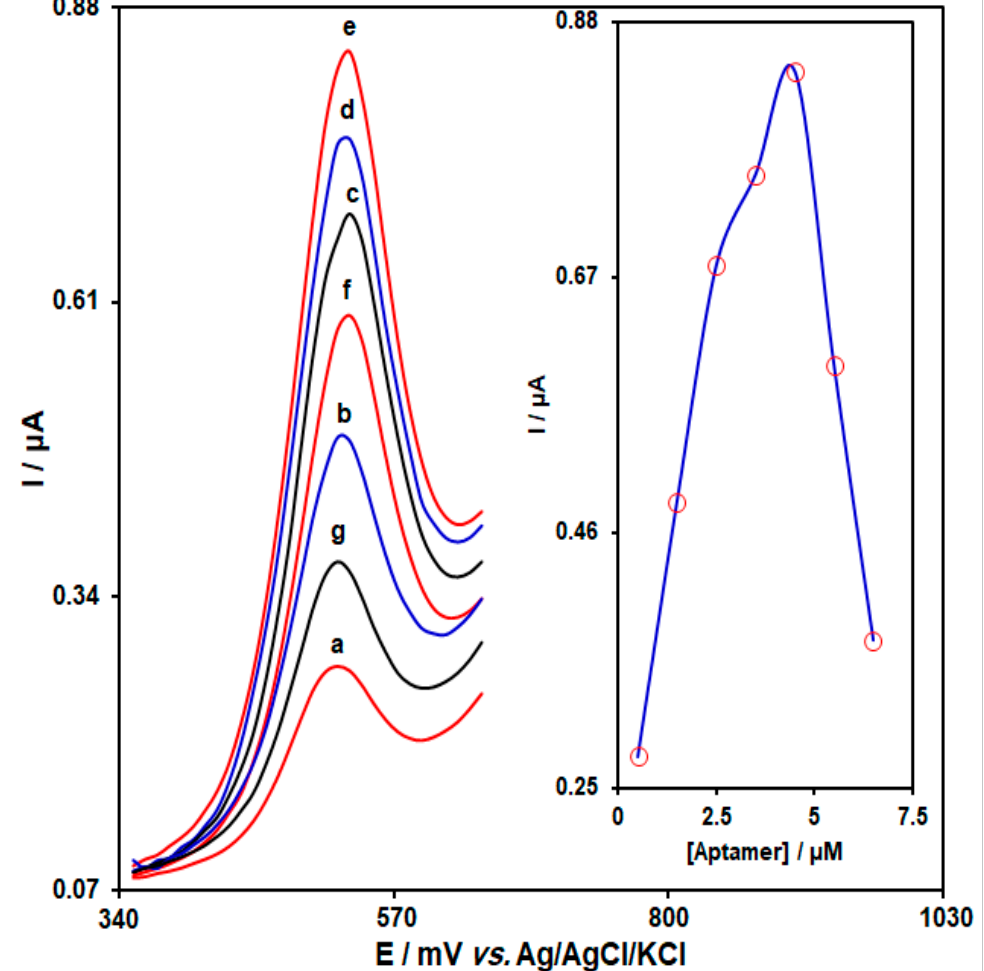
Figure 2. DPVs captured from Au-NS/CPE in PBS (0.1 M, pH = 7.0) with variable aptamer concen- trations ((a) 0.5, (b) 1.5, (c) 2.5, (d) 3.5, (e) 4.5, (f) 5.5, and (g) 6.5 μ M of aptamer). Inset: plot of peak current versus aptamer concentration, which ranged from 0.5 to 6.5 μ M.